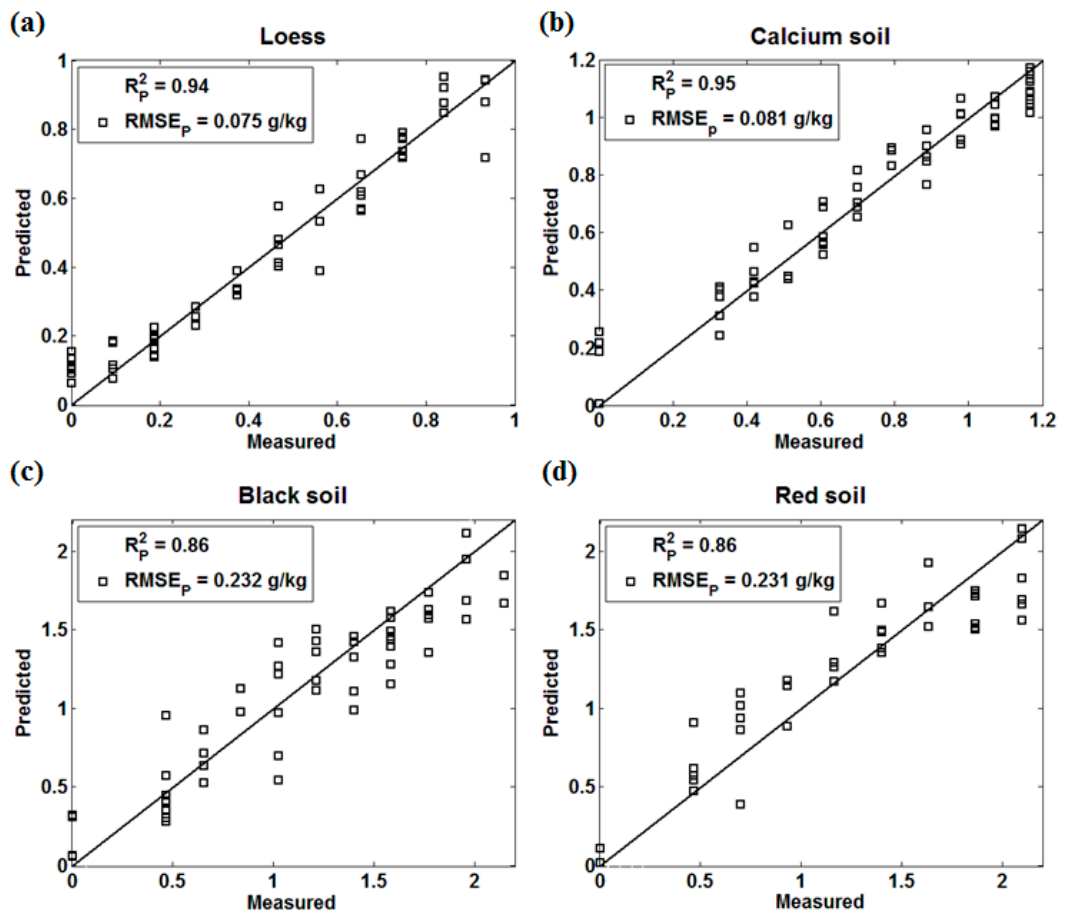
Figure 4. The Backward Interval Partial Least Squares (BIPLS) effect of four kinds of soils ( a ) Loess; ( b ) Calcium soil; ( c ) Black Soil; ( d ) Red soil.